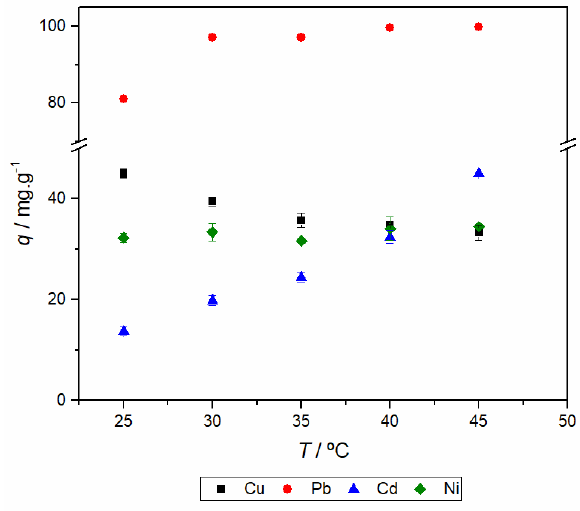
Figure 7. E ff ect of temperature on the adsorption performance of A_A + Figure 7. Effect of temperature on the adsorption performance of A_A+3A.